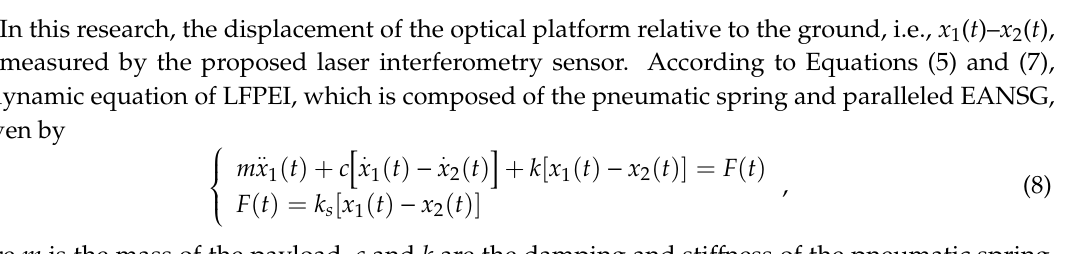
Figure 14. Scheme of relative displacement feedback.